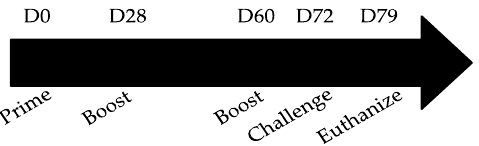
Figure 2. Outline of vaccination and challenge scheme. Mice were i.p. vaccinated with 10 µ g/immunogen + 10 µ g MPLA on days 0, 28, and 60. Mice were i.n. challenged (D72) with 10 6 PFU RSV/A2 and sera were collected prior to and 7 days post-challenge (D79).